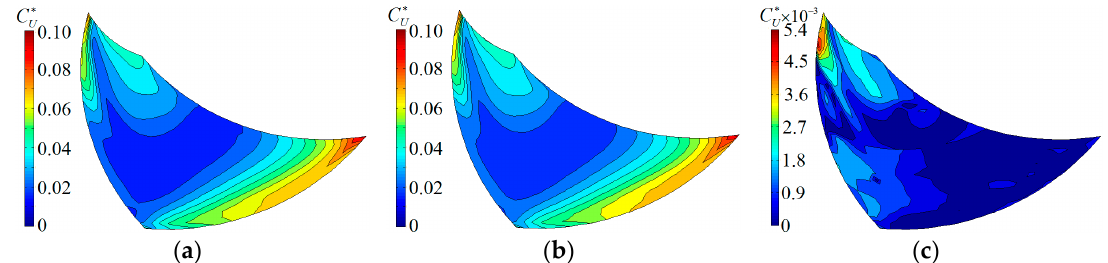
Figure 12. CFD calculation, POD reconstruction and their error of relative velocity fluctuation intensity on the single channel plane. ( a ) POD reconstruction; ( b ) CFD calculation; ( c ) Error.